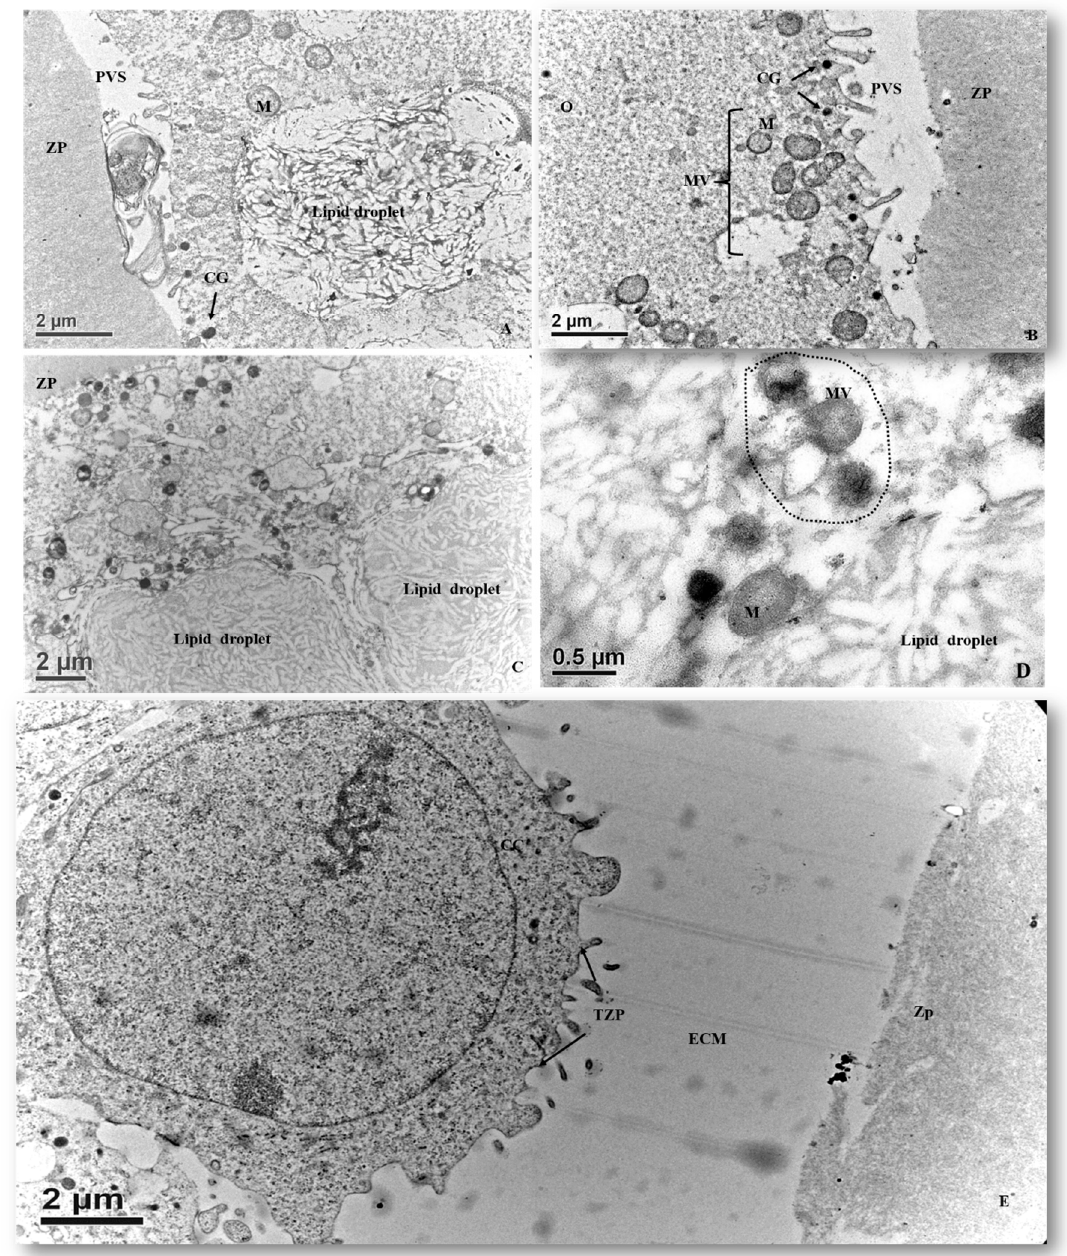
Figure 9. Ultrastructures of a matured porcine oocyte. ( A ) Electron micrograph of a matured oocyte with extruded polar body (PB) in the perivitelline space (PVS). ( B ) An electron micrograph of a matured oocyte. Note that the ruptures of cytoplasmic projections are visible in the PVS. The cortical granules (CGs) are more electron-dense (black) and form a ring-like structure beneath the oolemma membranes. ( C ) An electron micrograph showing lipid droplets in a matured oocyte. These lipid droplets are multi-structured and possess an electron-dense and streak-like morphology with mixed spots or border that are more grayish and amorphous. ( D ) Mitochondria are roundish with electrodense matrices that are centrifugally located in association with other organelles. ( E ) A micrograph of cumulus cells surrounding a matured oocyte. Note the enlarged ECM and retracted cytoplasmic projections, i.e., TZP. M, mitochondria; ZP, zona pellucida.